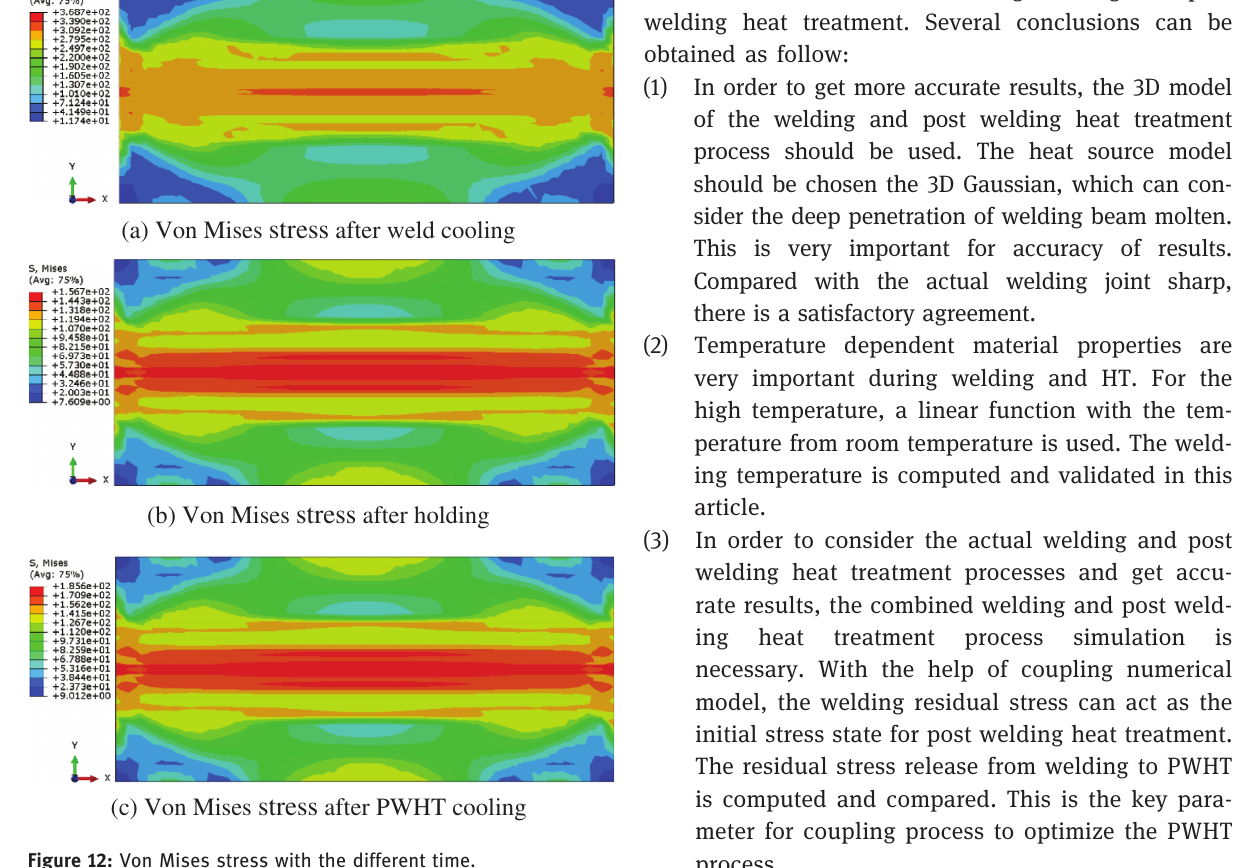
Figure 12: Von Mises stress with the different